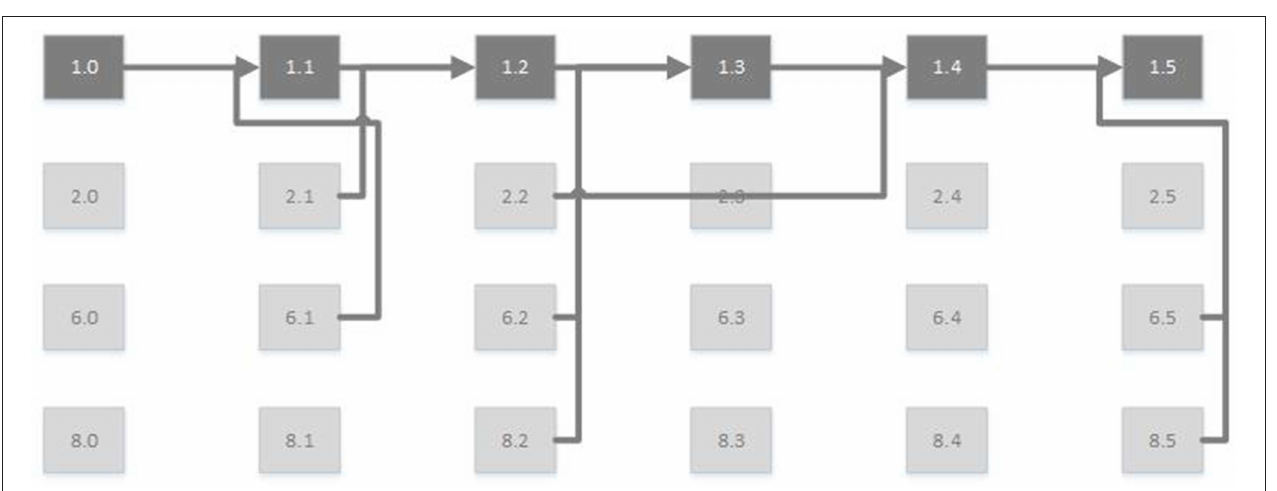
FIGURE 3 | Dependencies of dimension 1 “organization in general” (source: own